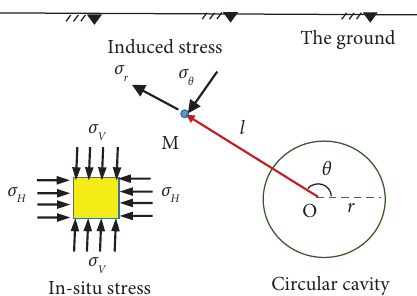
Figure 6: Schematic diagram of induced stress caused by exca- vation of circular cavity.